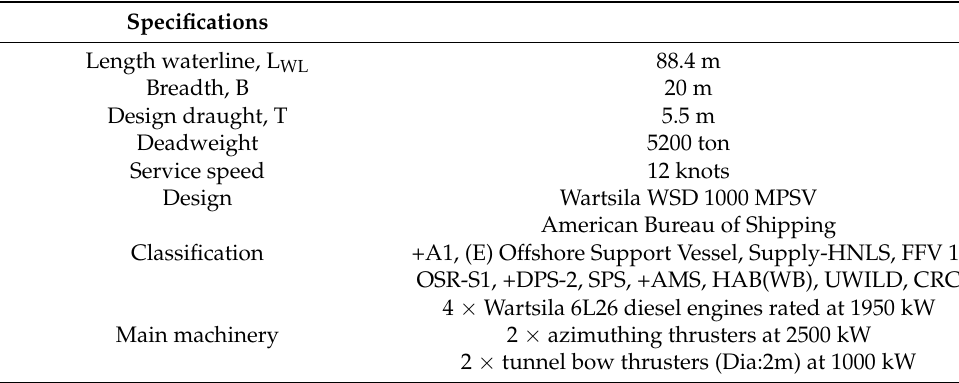
Table 2. Principal specifications of the